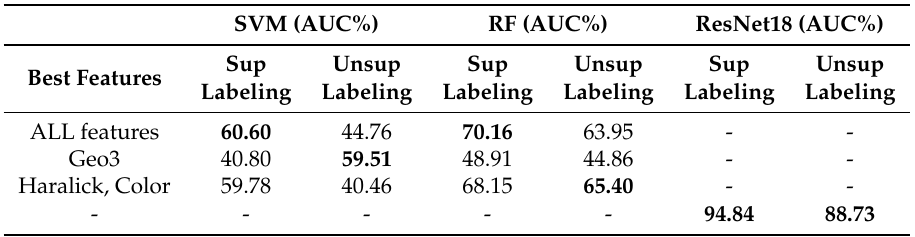
Table 3. Results of test data collected in the bean field with ResNet18, support vector machine (SVM), and random forest (RF). For the SVM and RF, only the results of the best selected features are presented.